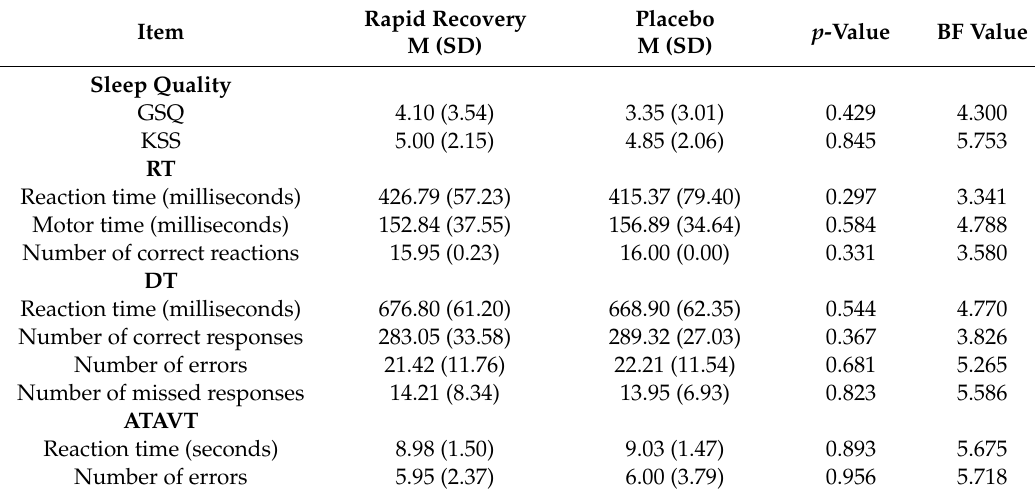
Table 2. Sleep quality and cognitive performance scores (means and standard deviations) in the Rapid Recovery and placebo conditions. Descriptive data is given in the left columns, including Groningen Sleep Quality Scale (GSQS), Karolinska Sleepiness Scale (KSS), reaction test (RT), determination test (DT) and adaptive tachistoscopic tra ffi c perception test (ATAVT) while the p value obtained from paired samples t-tests and the BF value obtained in case of non-significant di ff erences (i.e., p values < 0.05) are provided in the right columns.